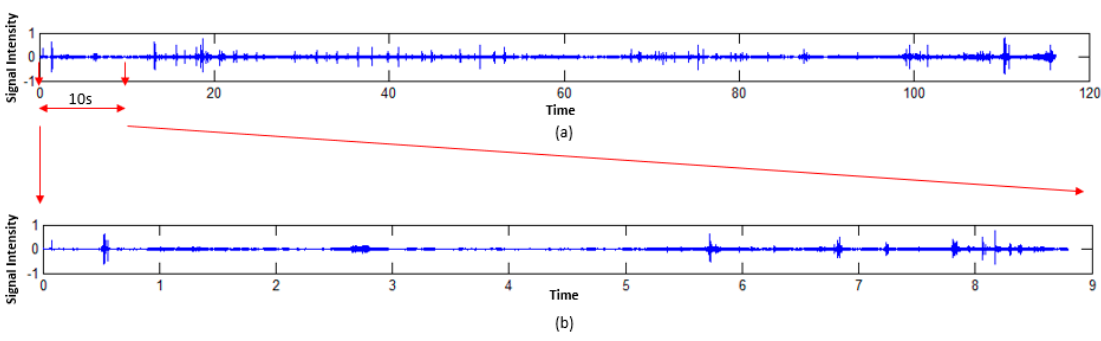
Figure 19. Signals recorded by the proposed data collector: ( a ) Original sound signal; ( b ) resampled sound signal. Agriculture 2020 , 10 , x FOR PEER REVIEW